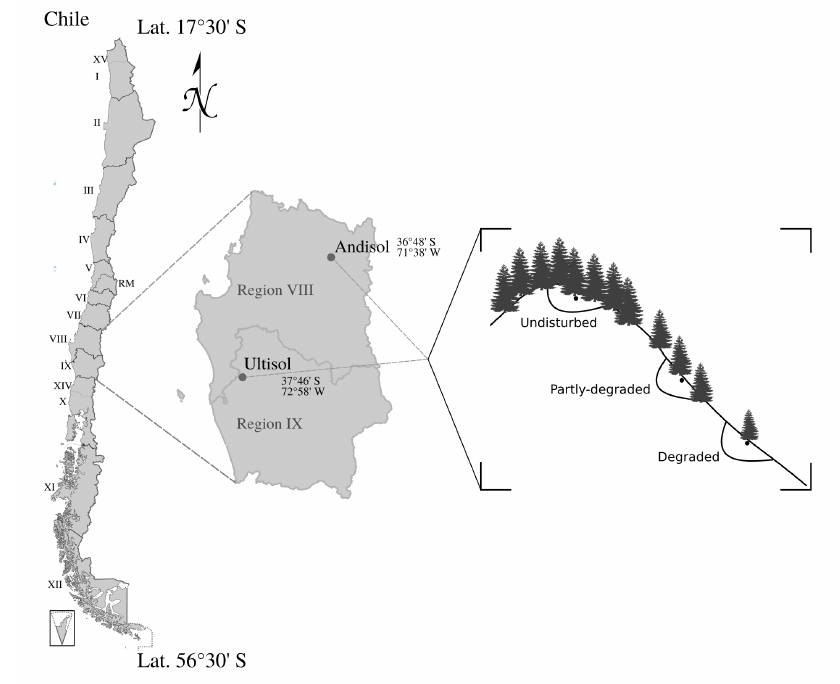
Figure 1. Location of the study sites. Two regions were selected; Region VIII (Biobio) and Region IX (Araucanía) which are located in the Andean and coastal ranges of Chile, respectively. In the box, a representation of the different Nothofagus obliqua forest conditions is shown for where the soil samples were